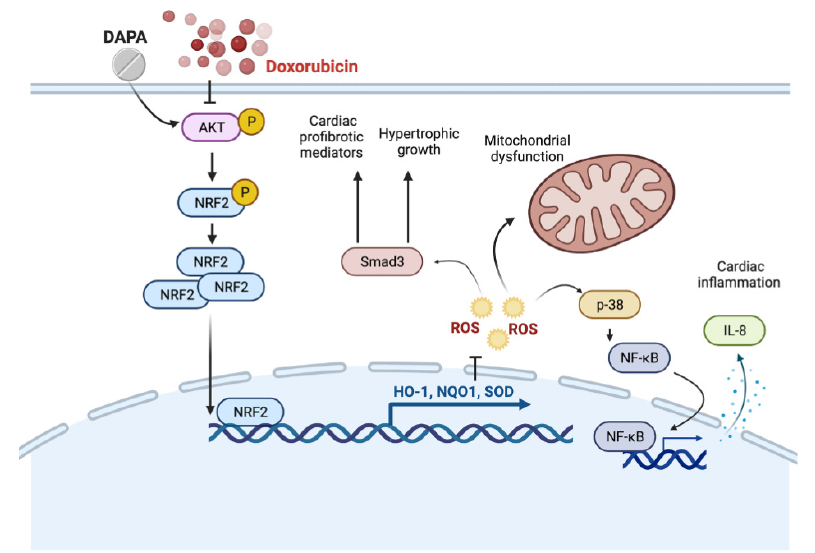
Figure 8. Schematic diagram of the major study findings. This study presents that DAPA reduces Dox-caused myocardial damage by regulating AKT-mediated oxidative stress, cardiac remodeling, and inflammation.